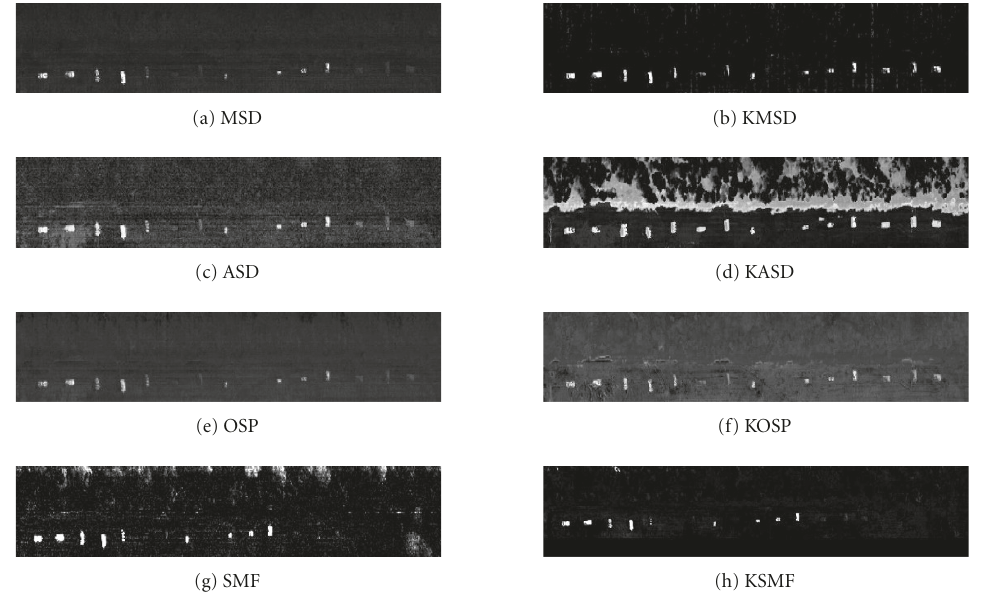
Figure 5: Detection results for the FR-I image using the conventional detectors and the corresponding kernel